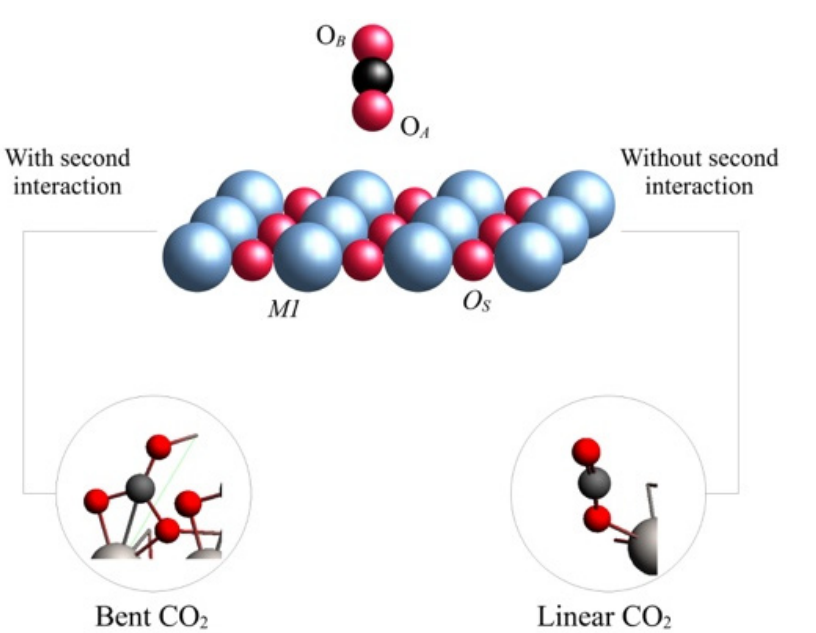
Figure 2. Representation of CO 2 adsorption on TiO 2 on rutile (right) and anatase (left). Atoms are labeled as follows: O A is the oxygen atom of CO 2 which displays the fi rst interaction with the surface; O B is the second oxygen atom of CO 2 ; O S is the metallic oxide oxygen; M1 is the metallic center.